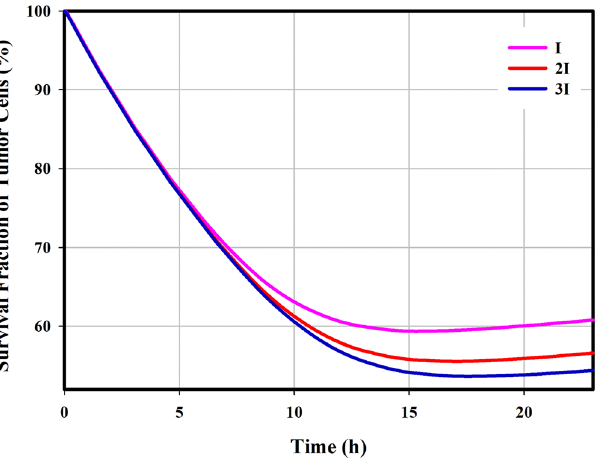
Figure 5. Cell mortality over time; Increasing the concentration enhances cell-death in a certain volume of , 2 I = 0.0382 kg , 3 I = 0.0573 kg tumor (cid:31) I = 0.0191 kg m 3 m 3 m 3 (cid:30)